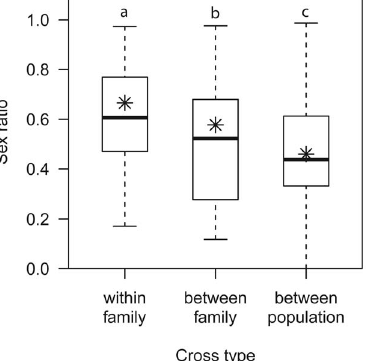
Figure 4. Boxplot of sex ratios for the three cross types. The bottom and top limits of the box are the 0.25 and 0.75 quartiles, respectively, and the bold black line indicates the median. Whiskers represent the minimum and maximum values. Asterisks show represent the predictions of the model with for the type of cross as fixed effect and maternal and paternal families as random effects. Different letters indicate a significant difference of least-square means (within-family/ between-family: z= 2 2.91, p =0.0102; within-family/between-popula- tion: z = 2 6.47, p , 0.0001; between-family/between-population: z=4.03, p